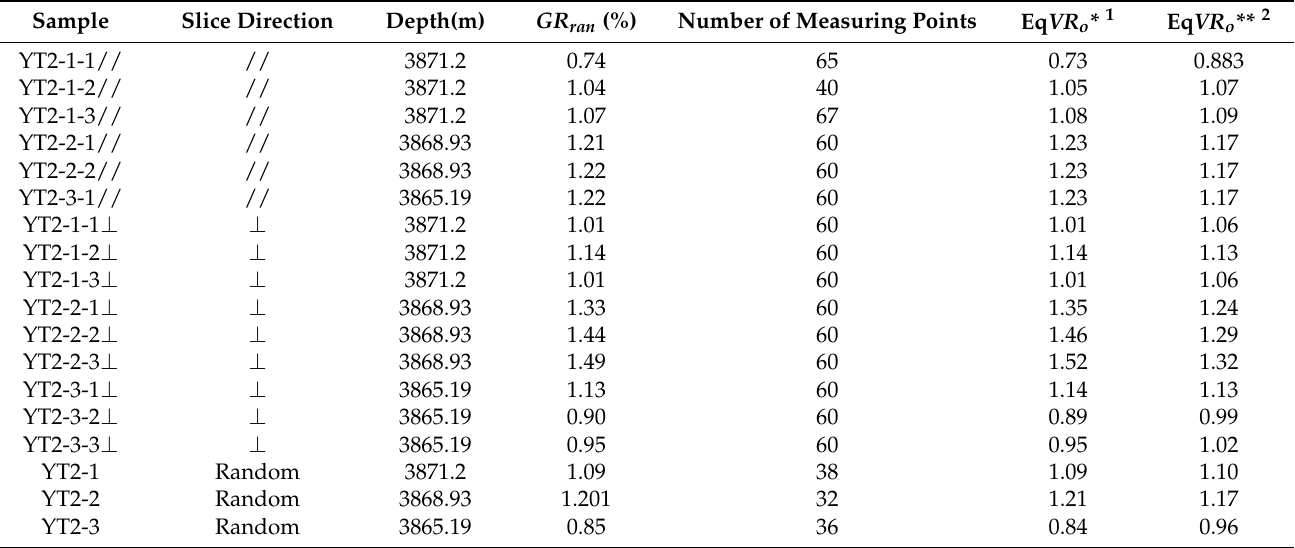
(Table 4, Figure 7C). Table 4. Calibration of sample